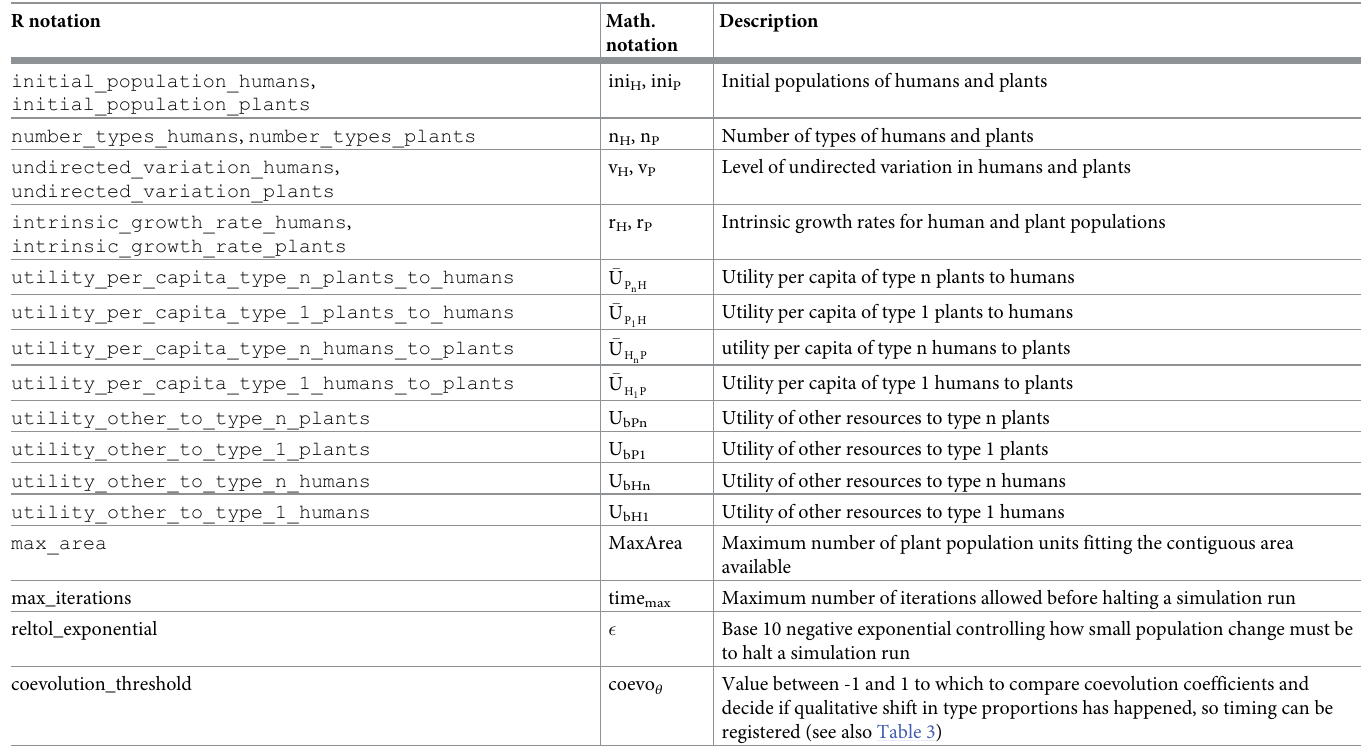
Table 1. Parameters.